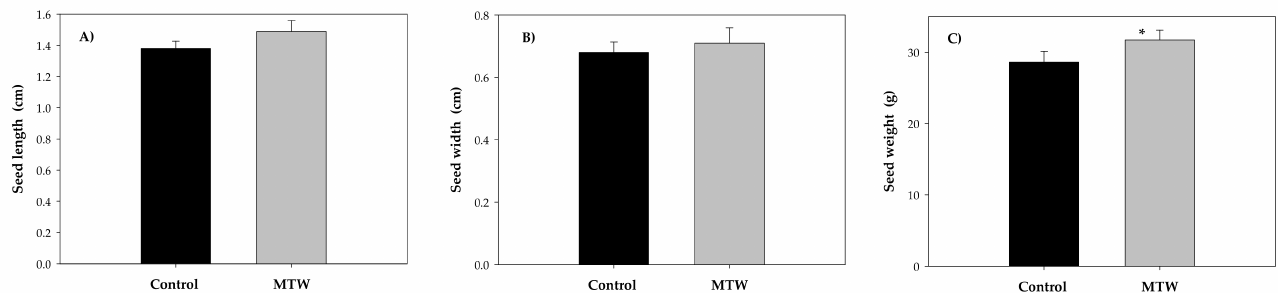
Figure 5. Mean values of seed length ( A ), seed width ( B ) and seed weight ( C ) in Phaseolus vulgaris L. grown with magnetically treated water. * indicates statistically significant differences ( p < 0.05). Control: plants grown without magnetically treated water, MTW: plants grown with magnetically treated water under a static magnetic field between 100 and 160